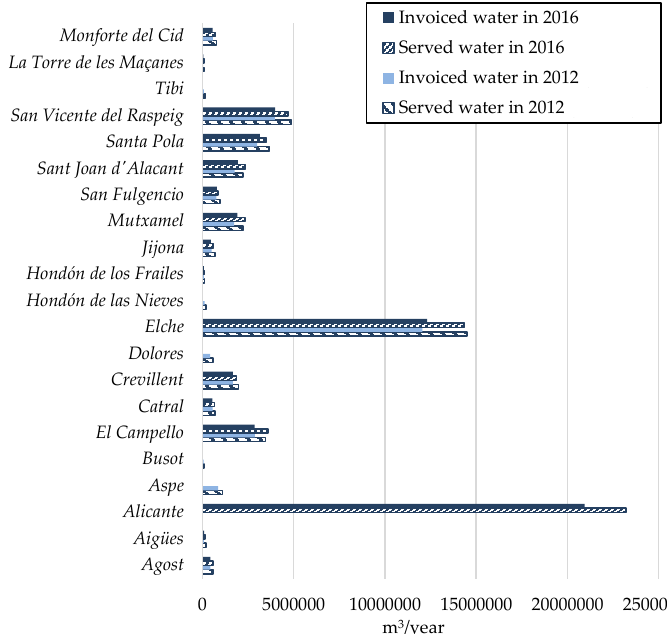
Figure 6. Urban and industrial water demand for the municipalities of the study area. Source: own elaboration from [40,54].